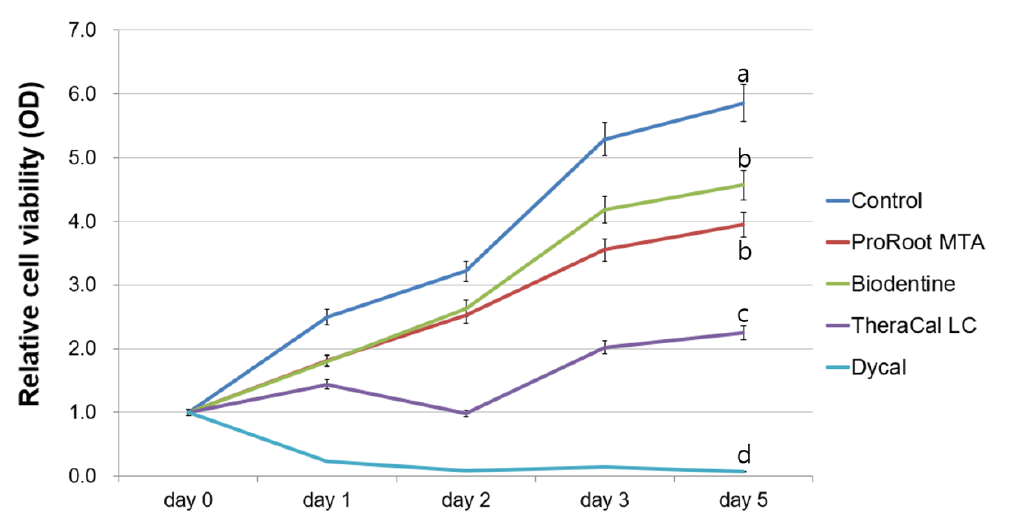
Figure 1. Evaluation of cell viability by methyl-thiazoldiphenyl-tetrazolium (MTT) assay. Different letters indicate statistically significant differences among experimental groups.